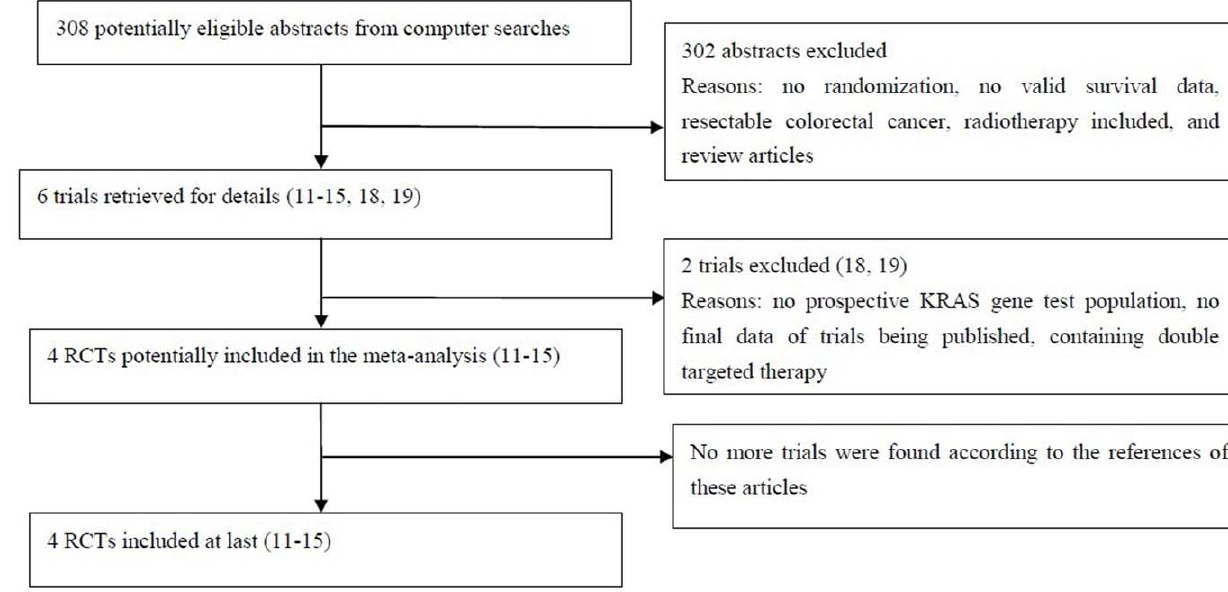
Figure 1. The flow chart.